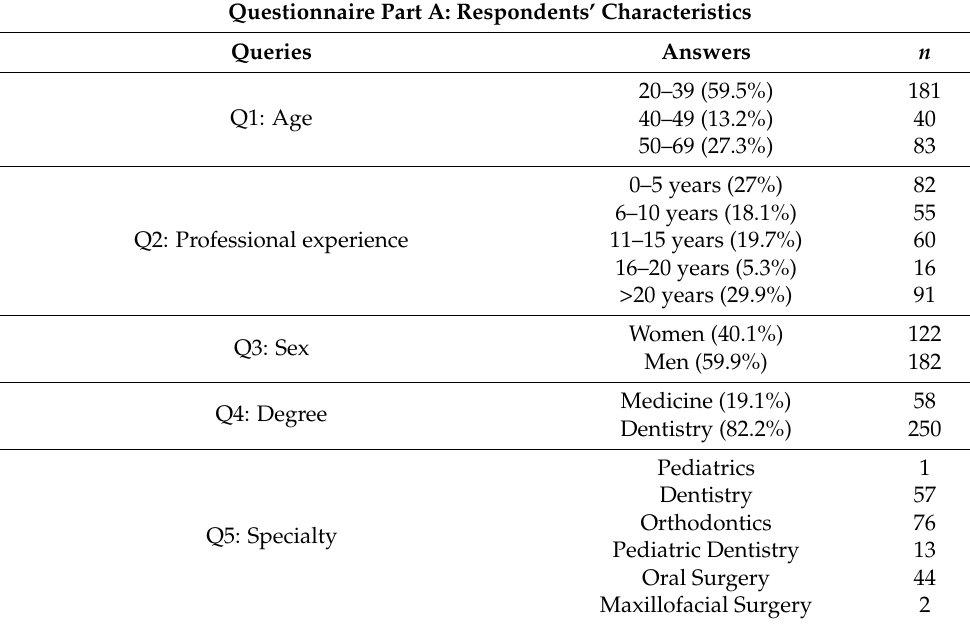
Table 1. Characteristics of the